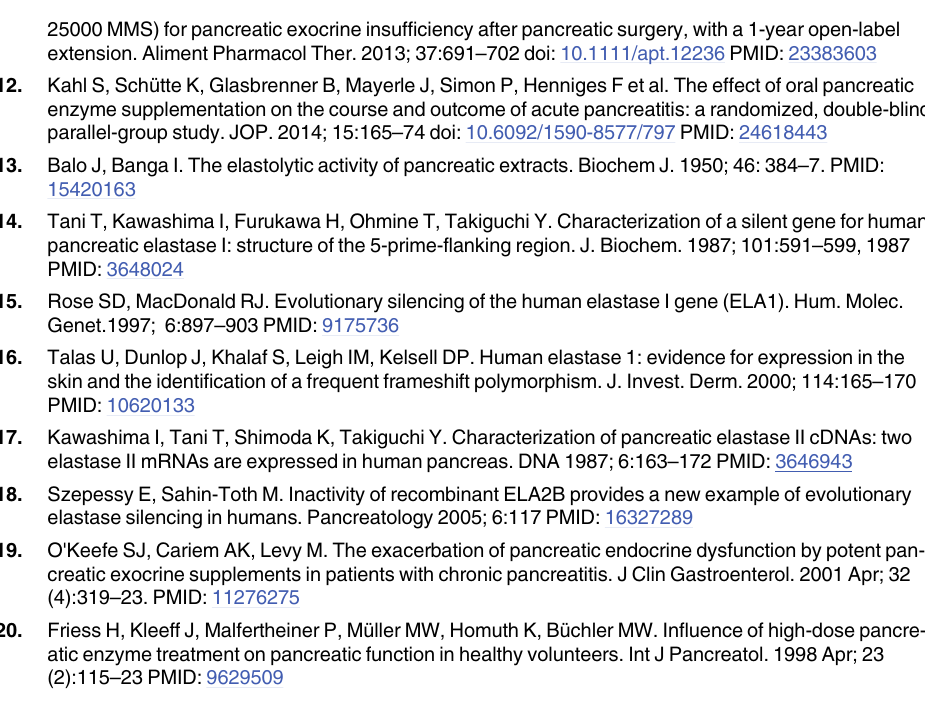
PLOS ONE | DOI:10.1371/journal.pone.0159363 July 26,